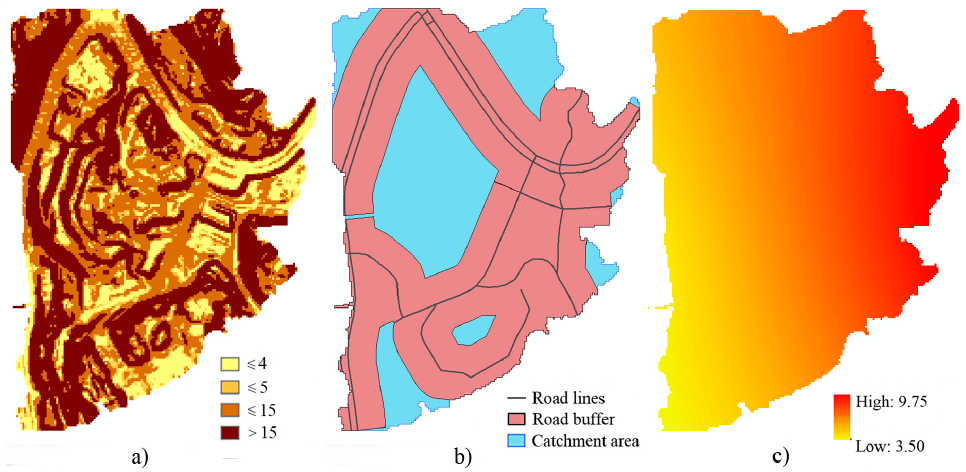
Figure 5. Feasible areas for the location of Sustainable Drainage Systems (SuDS) in terms of: ( a ) slope (%); ( b ) road buffer; and ( c ) water table depth (m).